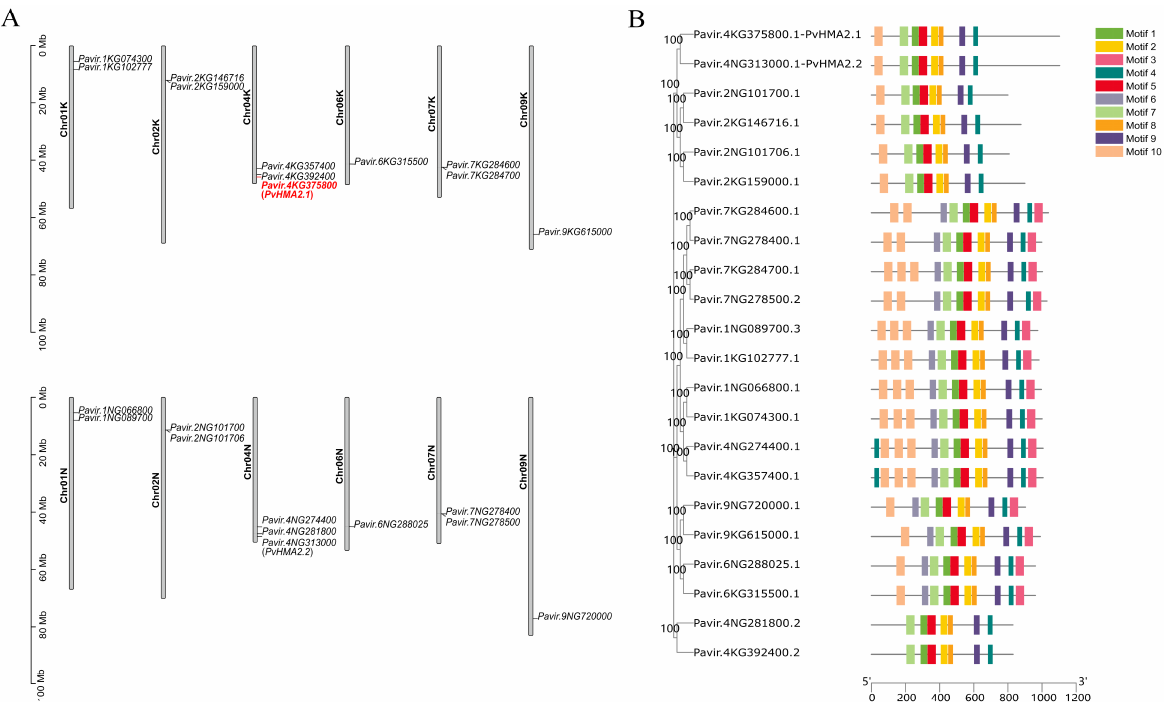
Figure 2. Chromosomal position and conserved motifs of 22 HMAs in P. virgatum . ( A ) Chromosomal mapping of HMA genes in P. virgatum . Chromosome name and gene identifier are indicated on the left and right of each chromosome, respectively. The ordinate is used as a reference for chromosome length. ( B ) Phylogenetic tree and conserved motifs of switchgrass HMA proteins. The tree of the HMA proteins was constructed using the multiple sequence alignment of MAFFT, and the phylogenetic tree was constructed using MEGA 11, using the neighbor-joining method with 1000 bootstrap replicates. The numbers next to the branching point indicate the percentage of replicates supporting each branch. The conserved motifs of the HMA proteins were analyzed by using the online program MEME with ten motifs. The abscissa represents the scale for sequence length of the HMA proteins, and the boxes with different colors represent different motifs in the corresponding position of each